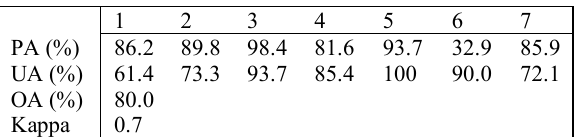
Table 6.1 Error matrix (pixel count) 2019 year